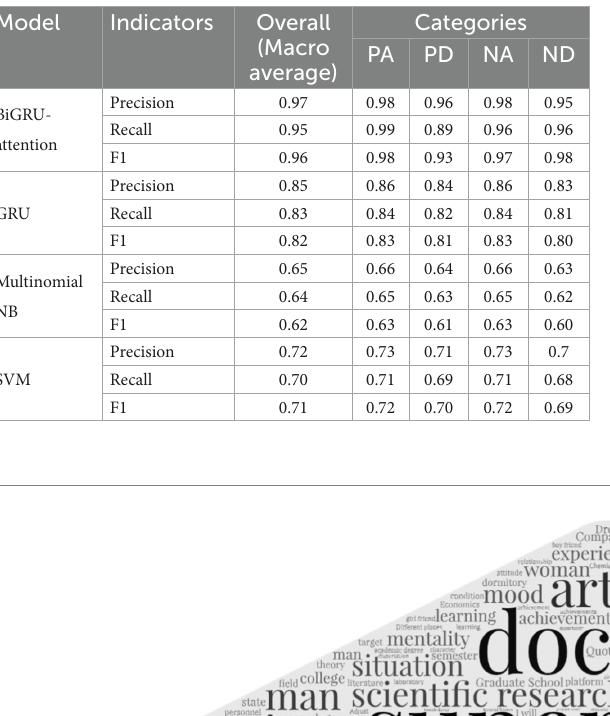
TABLE 2 Performance comparison for each model.